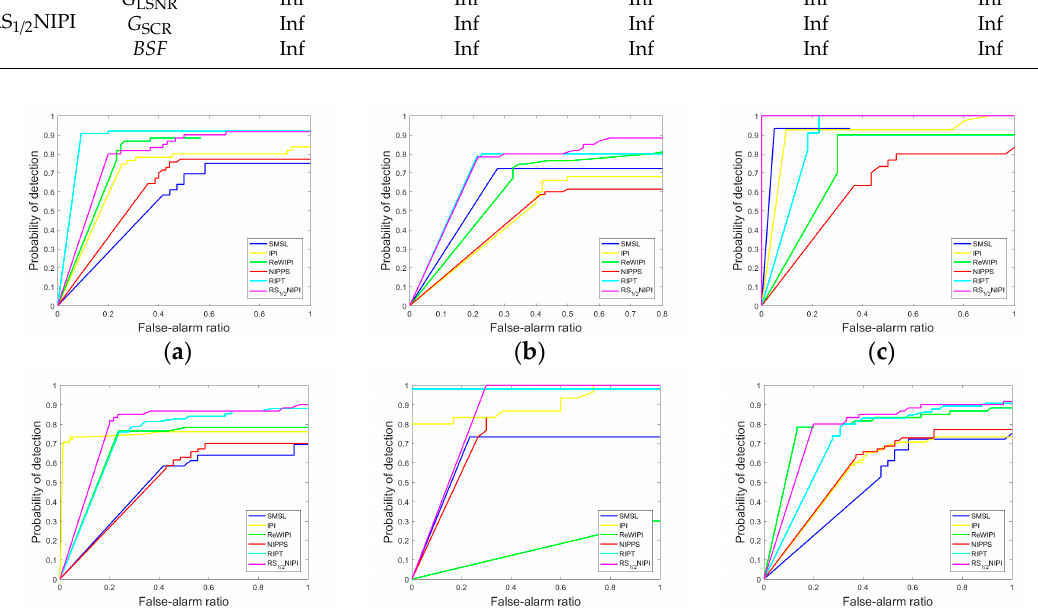
Figure 10. The ROC curves of detection results obtained using different methods ( a ) Sequence 1. ( b ) Sequence 2. ( c ) Sequence 3. ( d ) Sequence 4. ( e ) Sequence 5. ( f ) Sequence 6.